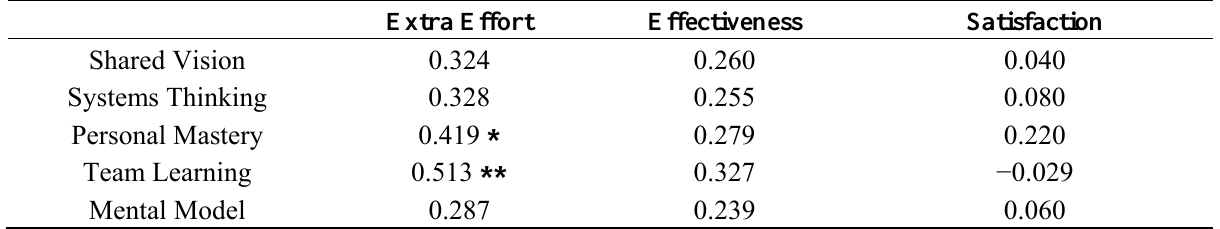
Table 7. Correlations between learning organization characteristics and